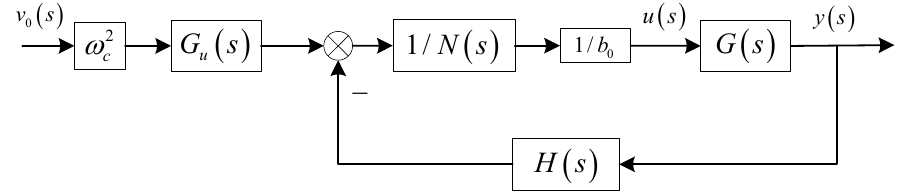
Figure 6. Conversion diagram of the improved LADRC control structure.